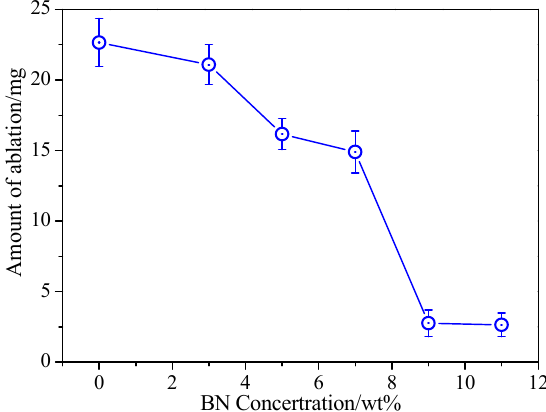
Figure 7 . Arc ablation resistance of PTFE/BN composites with various BN loadings.